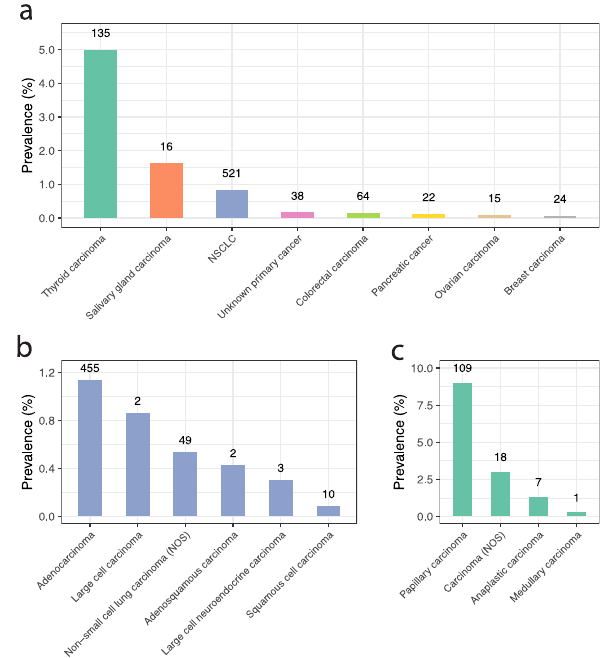
Fig. 1 Prevalence of RET fusions varied depending on tumor types. a The 8 tumor categories had varying prevalence of RET fusion (only tumor categories with more than 10 instances were included in fi gure and tumor categories were composed of tumor types with at least 1 instance as grouped in Supplementary Table 2). The prevalence of RET fusions also varied in subtypes of b NSCLC and c thyroid carcinoma. The two tumor types with the highest number of RET fusion were lung adenocarcinoma and thyroid papillary carcinoma and they had a prevalence rate 1.14% and 9.09%, respectively. NOS not otherwise speci fi ed. Number on top of bar indicates total number of RET fusion